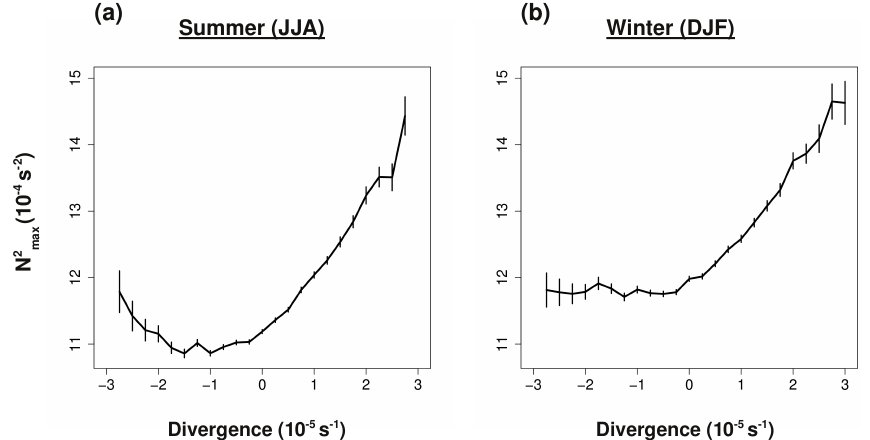
Figure 3. Diagrams of horizontal wind divergence vs. TIL strength ( N 2 max ) for the latitude band 10 ◦ S–10 ◦ N. (a) belongs to the summer season (JJA) and (b) to the winter season (DJF). Vertical bars denote 1 standard deviation of the mean